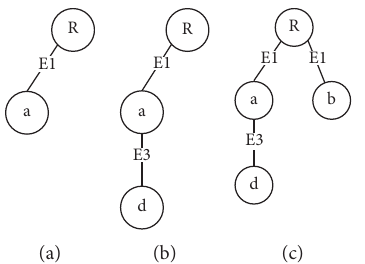
Figure 9: Maximum common graphs: (a) maximum common graph after step 1; (b) maximum common graph after step 2; (c) maximum common graph after step 4.